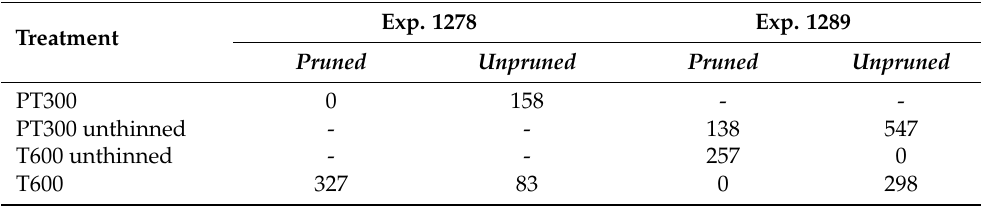
Table 2. Number of pruned and unpruned trees available for the analysis of crop tree growth and of pruning effects on individual tree growth. Nominal thinning treatment indicates the treatment applied during the observation period (PT300 or T600) or the treatment scheduled to be initiated later (PT300 unthinned and T600